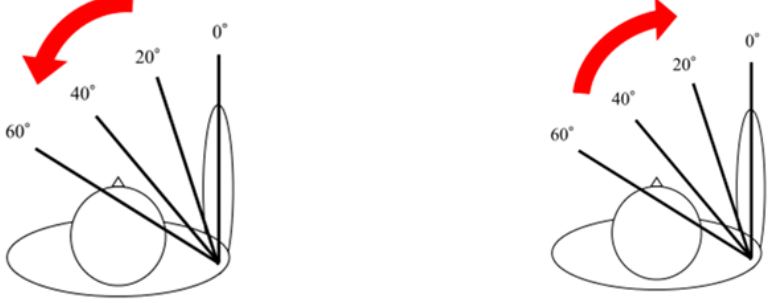
Figure 3. The movement speeds for each angle of 0–20, 20–40, and 40–60 degrees during internal and external rotation were measured.